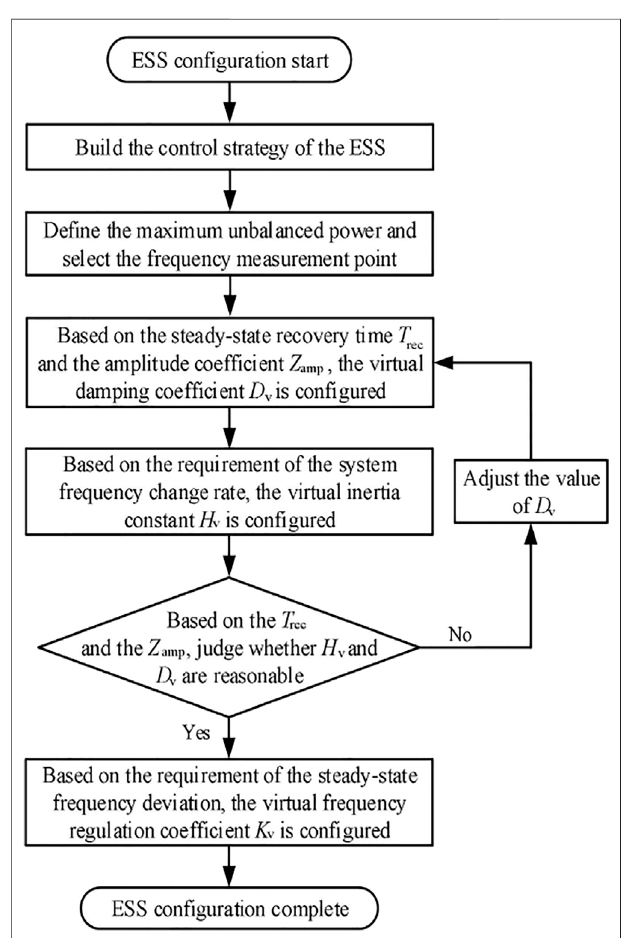
FIGURE 19 | Flow chart of the ESS con fi guration